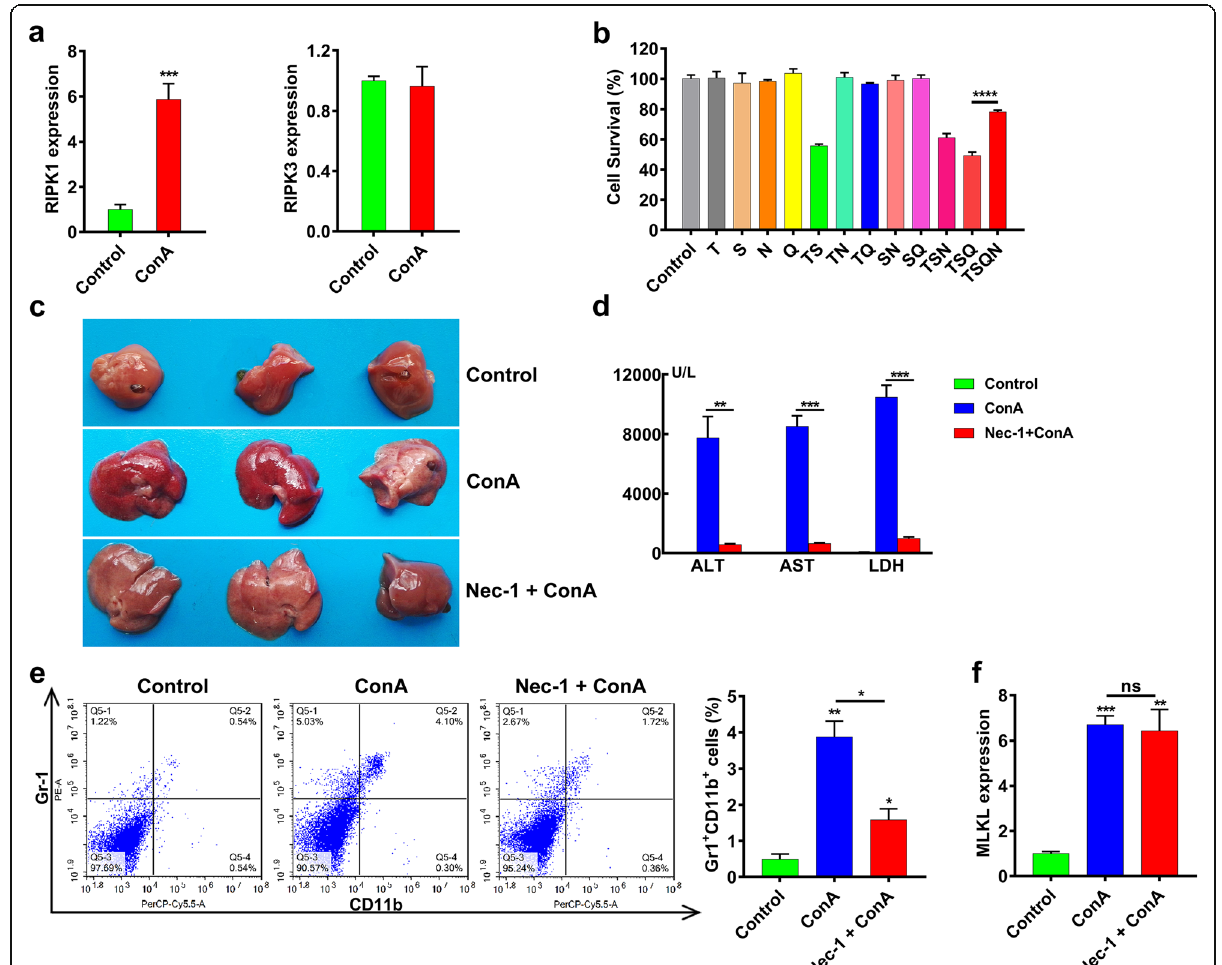
Fig. 2 Role of RIPK1 and RIPK3 in ConA-induced acute liver injury. Both in vitro and in vivo studies were conducted to investigate the roles of RIPK1 and RIPK3 in ConA-induced acute liver injury. a The RT-PCR analysis showed the intrahepatic mRNA level of RIPK1 was significantly elevated in mice treated with ConA compared with untreated mice, while no significant difference in the intrahepatic mRNA level of RIPK3 between ConA-treated and untreated mice. b L929 cells treated with RIPK1 inhibitor Necrostatin-1 (N) were found resistant to the necroptosis induced by the combination of hTNF- α (T), Smac-mimetic (S) and caspase-inhibitor QVD-OPH (Q). c The gross images of livers showed of Nec-1 pretreatment alleviated ConA-induced liver injury. d The Nec-1 pretreatment attenuated the increase of serum ALT, AST and LDH induced by ConA. e The Nec- 1 pretreatment reduced the infiltration of Gr1 + CD11b + cells in the liver of ConA-treated mice. f The hepatic expression of MLKL, a key protein in necroptosis, was increased in ConA-treated mice compared to untreated mice. ( *p < 0.05, **p < 0.01, ***p < 0.001, ****p < 0.0001